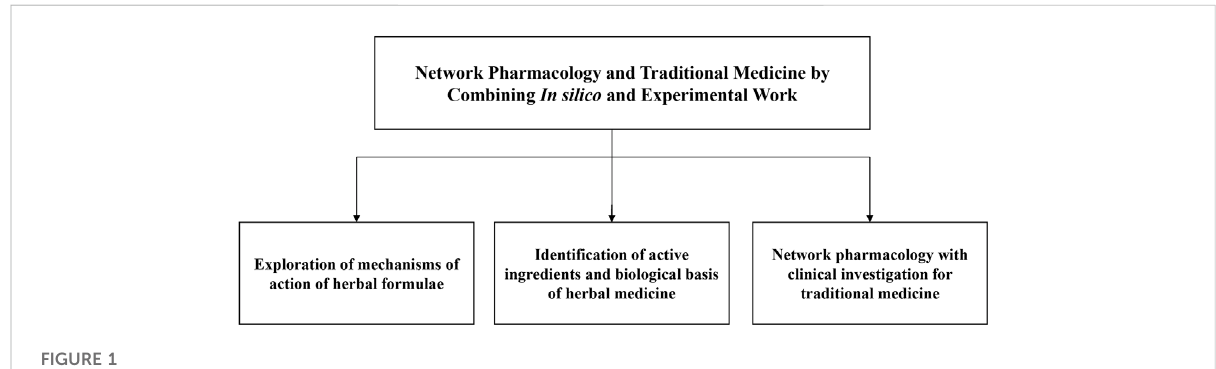
FIGURE 1 Summary of the 39 articles in this research